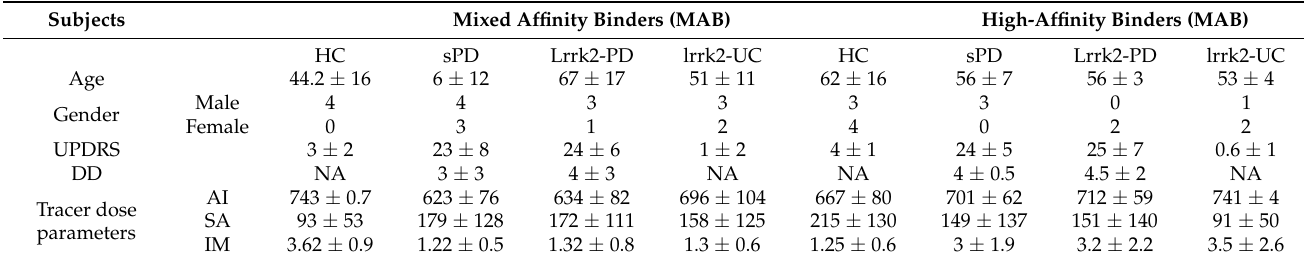
Table 1. Demographic and clinical characteristics of subjects.